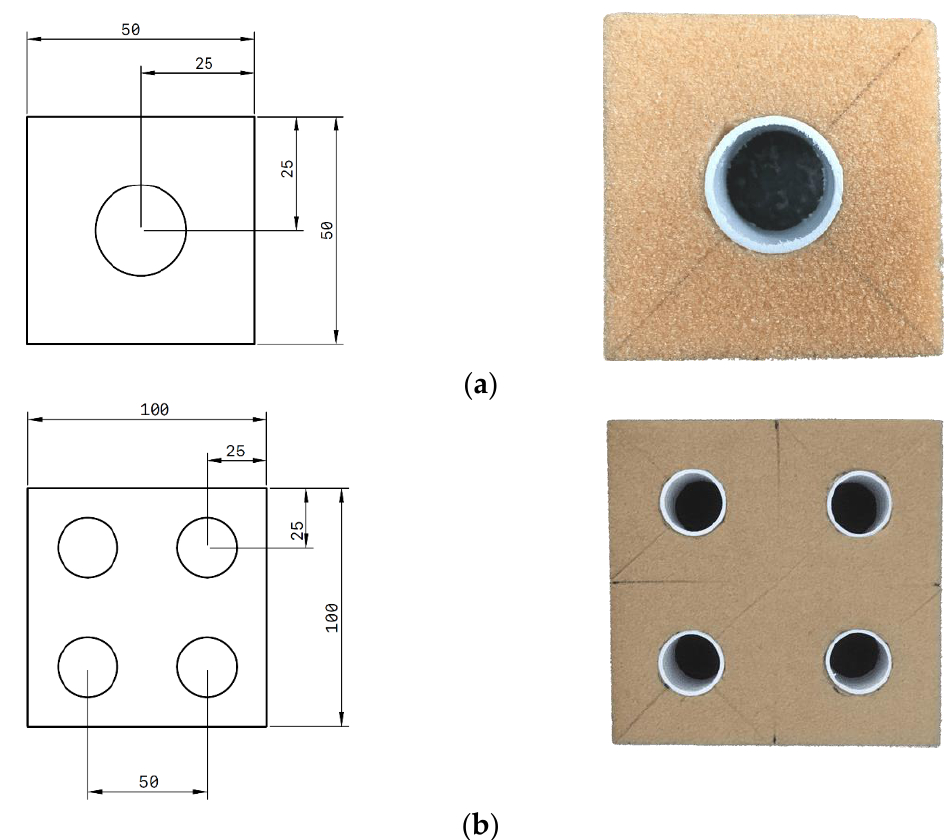
Figure 1. Dimension and positioning for ( a ) single tube and ( b ) multiple tube reinforced foam structure.